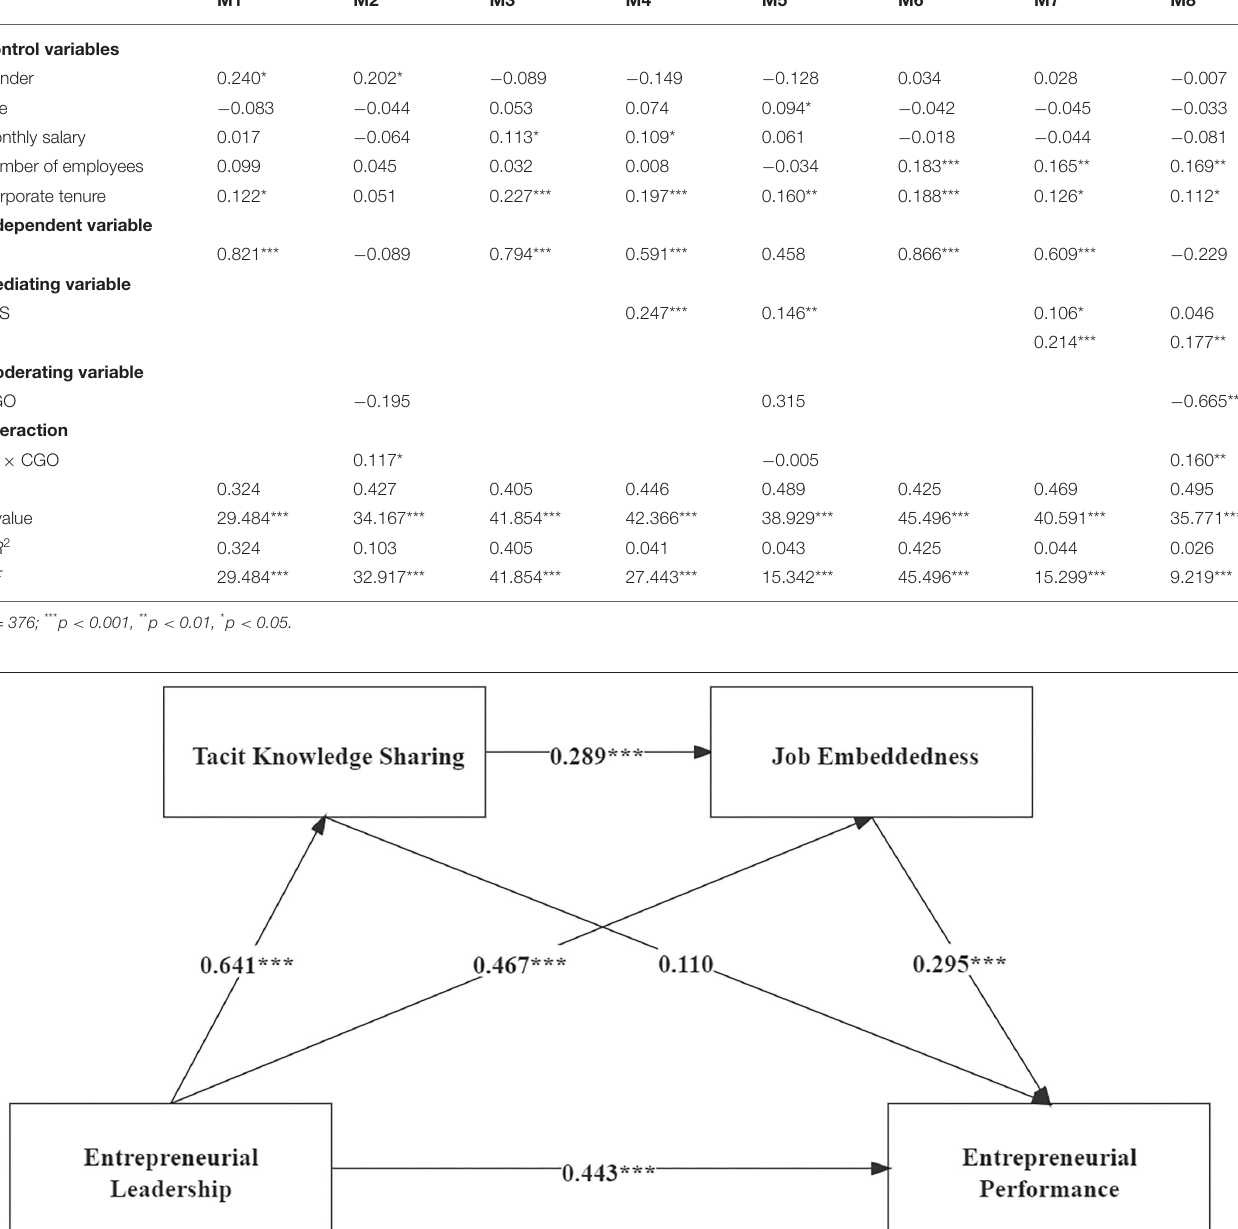
mediating association of TKS and JE between EL and EP was low [ b = 0.025, SE = 0.011, 95% CI = (0.007, 0.049)], medium [ b = 0.034, SE = 0.012, 95% CI = (0.014, 0.060)] and high [ b = 0.043, SE = 0.016, 95% CI = (0.017, 0.079)]. None of these confidence intervals include 0, so hypothesis 2, hypothesis